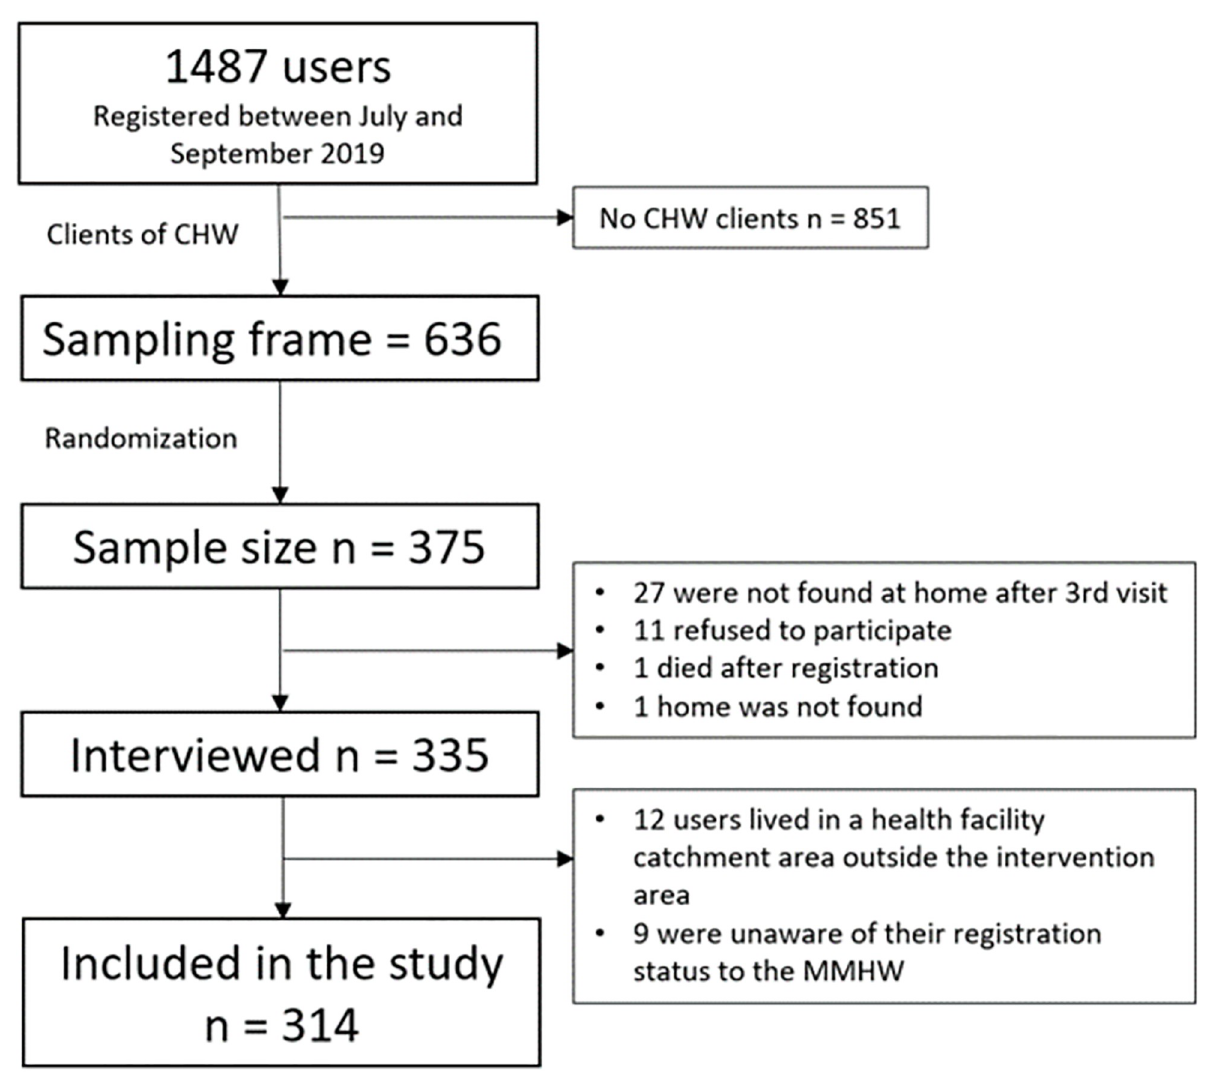
Fig 2. Flowchart of recruitment of women who enrolled for the MMHW intervention between July 1 and September 30, 2019 in Analamanga, Madagascar. CHW, community health worker; MMHW, Maternal Mobile Health